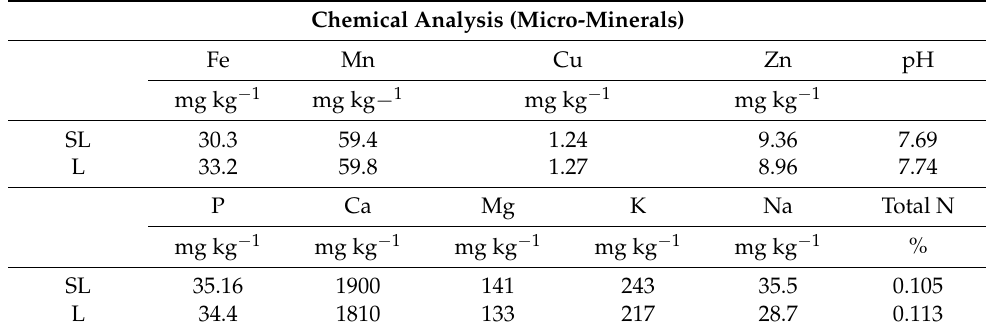
Table 1. Soil analysis for the experiment (mineral/chemical